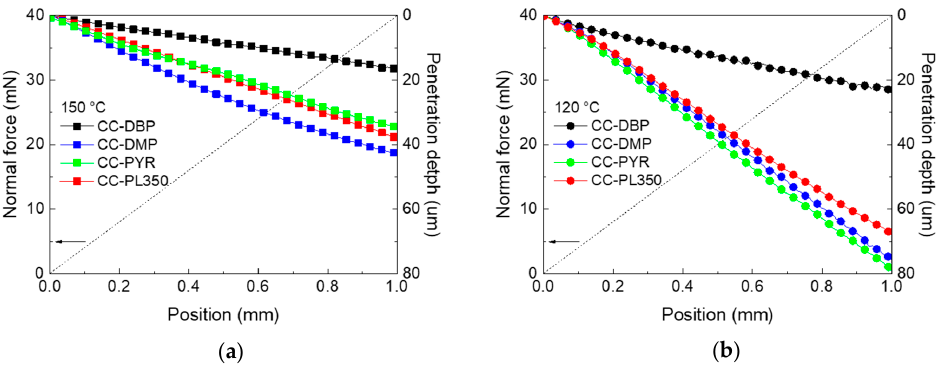
Figure 6. Penetration depth profiles of clearcoat films cured at ( a ) 150 °C and ( b ) 120 °C.